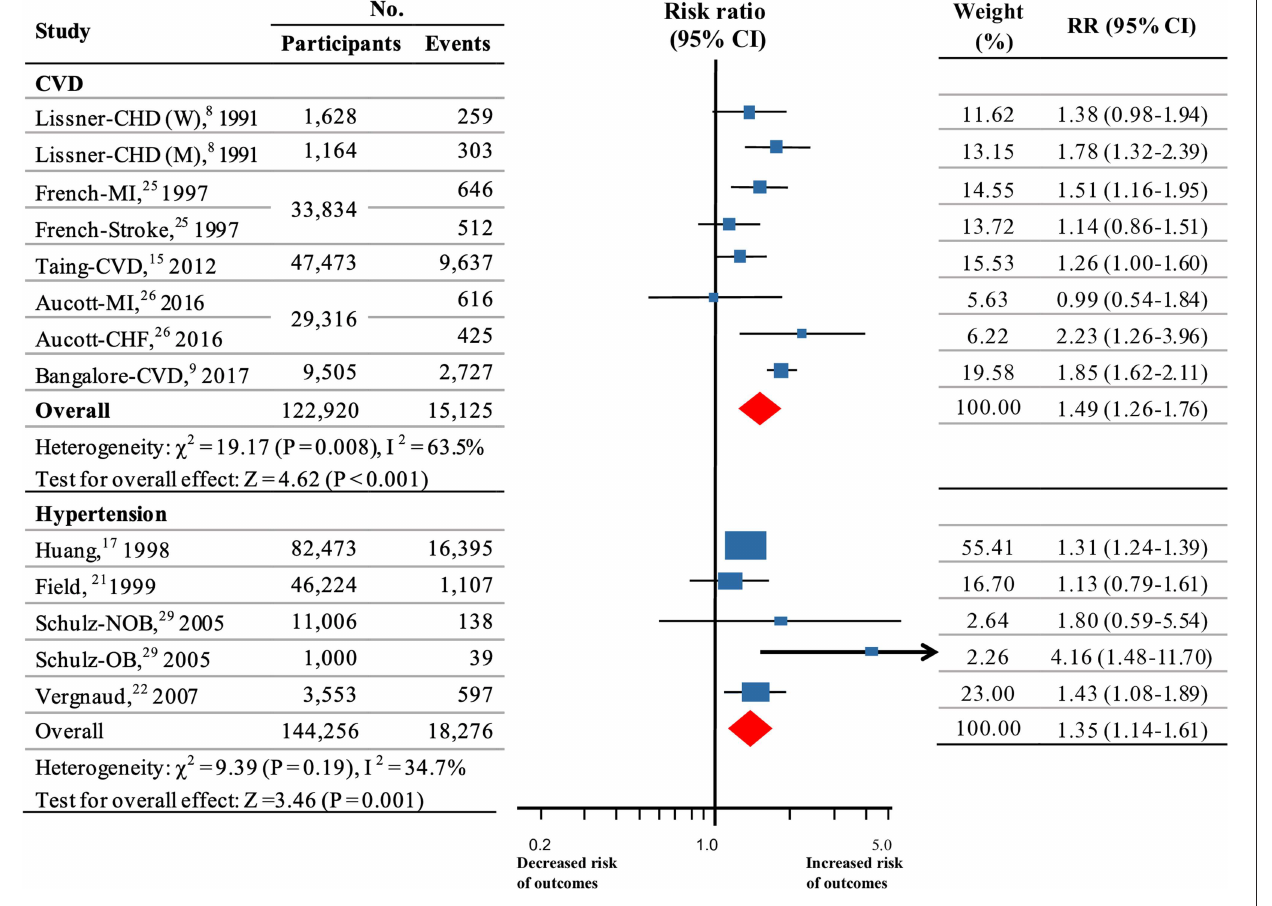
FIGURE 3 | Summary RRs for the association between weight fluctuation and CVD and hypertension. Size of data markers is proportional to the weight of each report. RR and 95% CIs were calculated using the random-effects model used to pool data. Error bars indicate 95% CIs. RR data are rounded to 2 decimal places; error bars reflect unrounded values. RR, relative risks; CI, confidence interval; CVD, cardiovascular disease; M, men; W, women; MI, myocardial infarction; CHF, congestive heart failure; CHD, coronary heart disease; OB, weight fluctuations in obese; NOB, weight fluctuations in